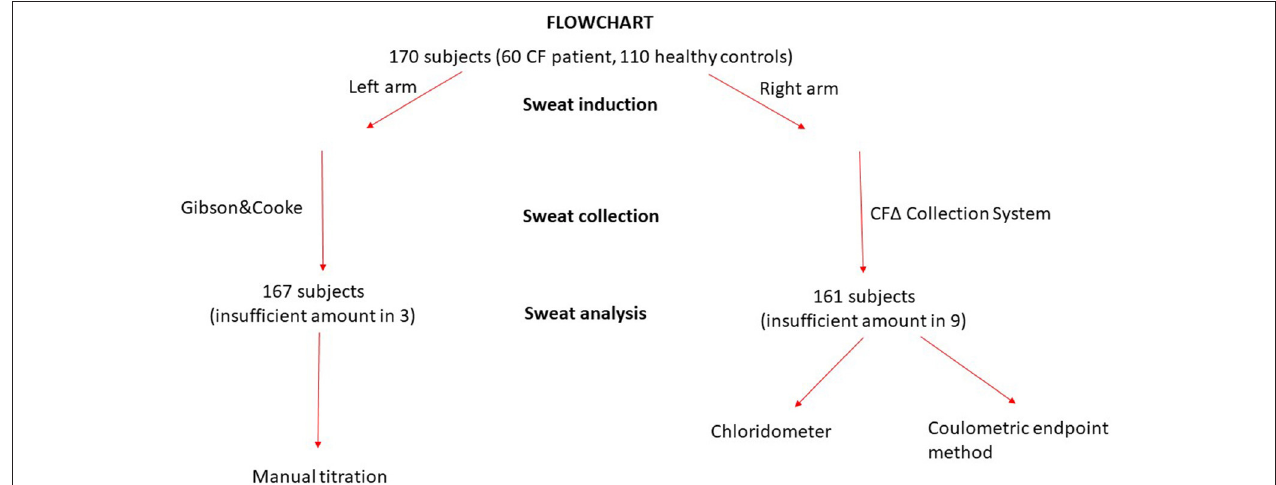
FIGURE 1 | Flowchart of the